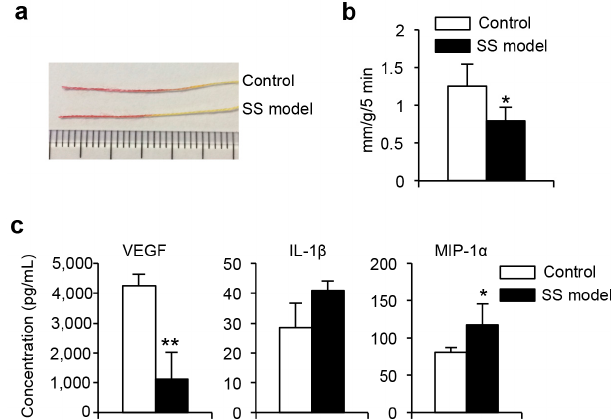
Figure 1. Dry eye in the Sjögren’s syndrome (SS) model mice. ( a ) Tear volume was determined by measuring the length of the phenol-red threads remaining in contact with the eye at 5-min intervals after intraperitoneal injection of pilocarpine in anesthetized mice; ( b ) Tear volumes were reported as tear volume/body weight at 10 min. Data are means ± standard deviation (SD) of eight mice for each group; and ( c ) Twenty cytokines, chemokines, and growth factors were quantified in tears using the Luminex assay. Vascular endothelial growth factor (VEGF), interleukin (IL)-1 β , and macrophage inflammatory protein (MIP)-1 α concentrations are means ± SD of five mice for each group. * p < 0.05, ** p < 0.005.